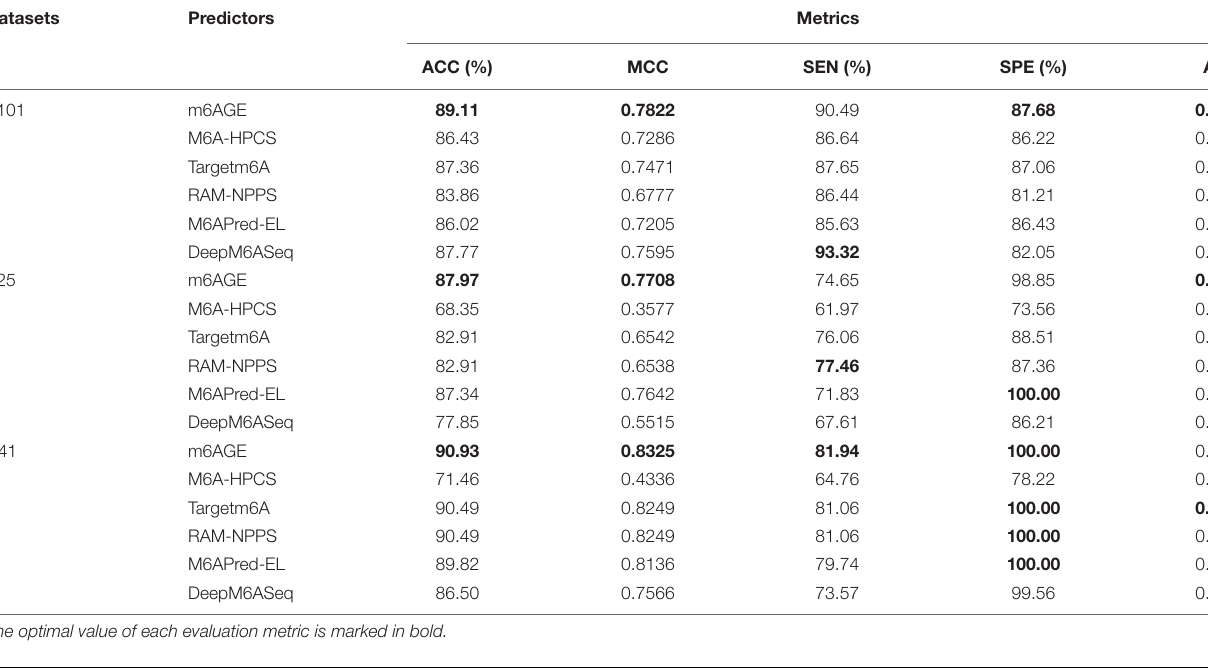
TABLE 1 | The performance of m6AGE against other existing predictors.